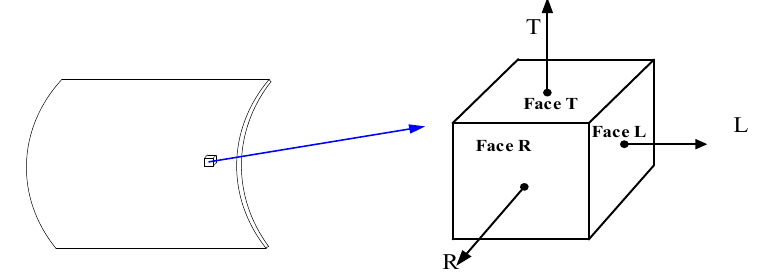
Figure 4. Specimens for microstructure and texture test.